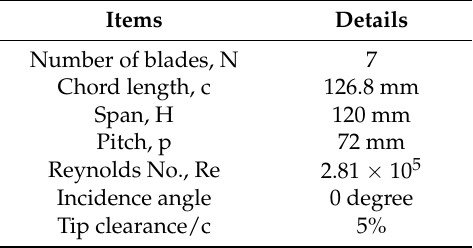
Figure 2 . Schematic of compressor cascade and the SPIV measurement configuration. Table 1. Cascade parameters and test condition.